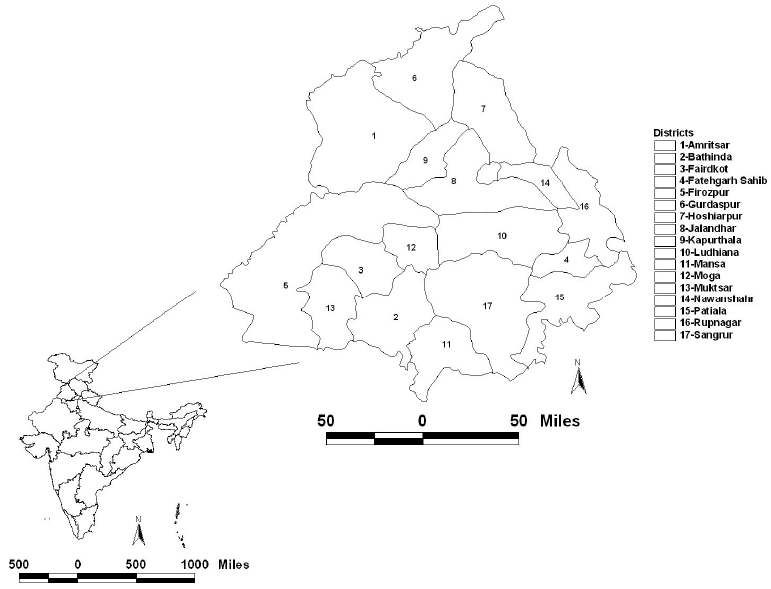
Figure 1. Study area location map depicting Punjab state in India with different districts.